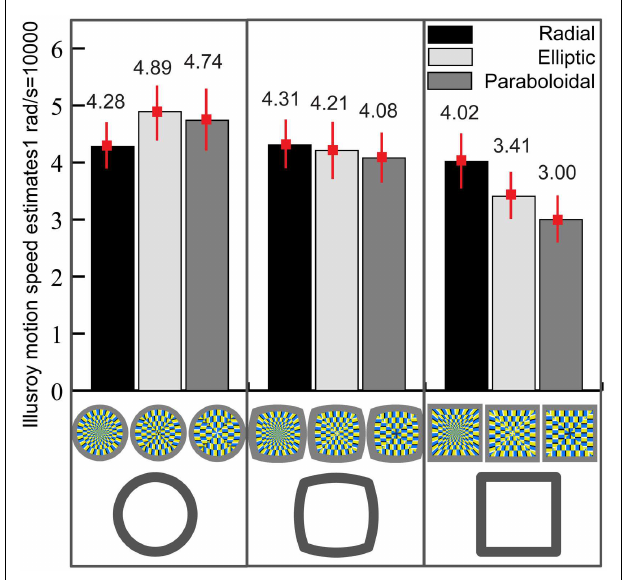
FIGURE 5 |The interaction between the contour and the layout. Vertical bars denote ± standard errors. Speed unit was set in a range from 1 to 1000. Speed of 1000 corresponded to